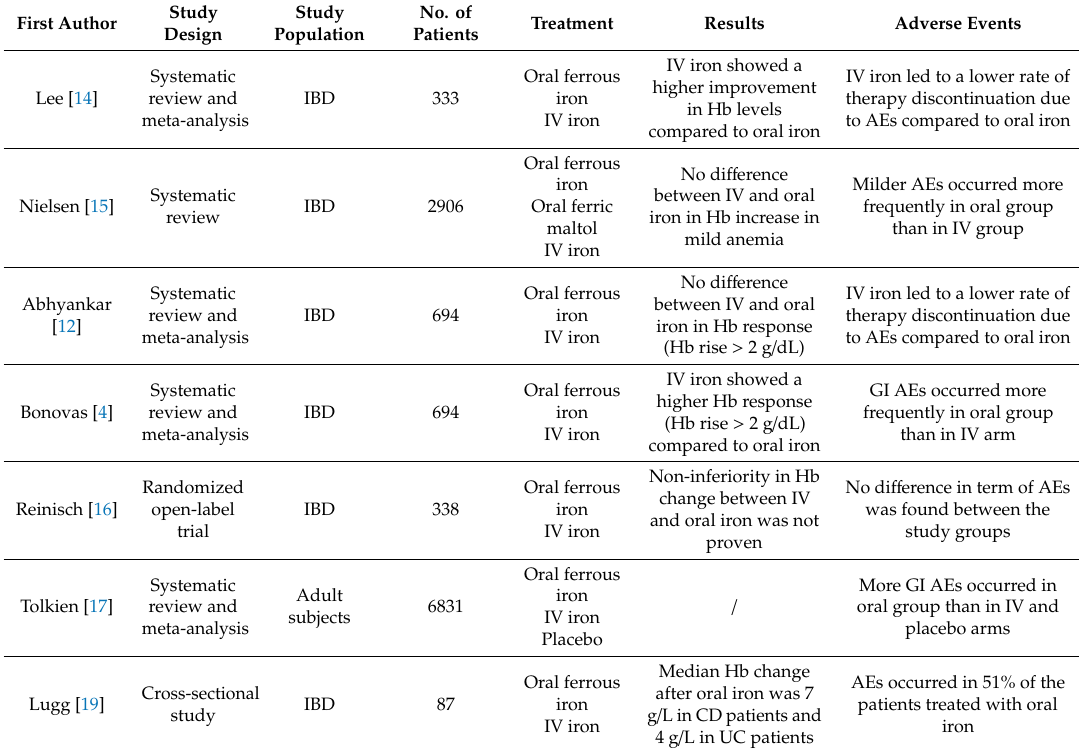
Table 1. Main characteristics of ferrous oral iron studies for the treatment of